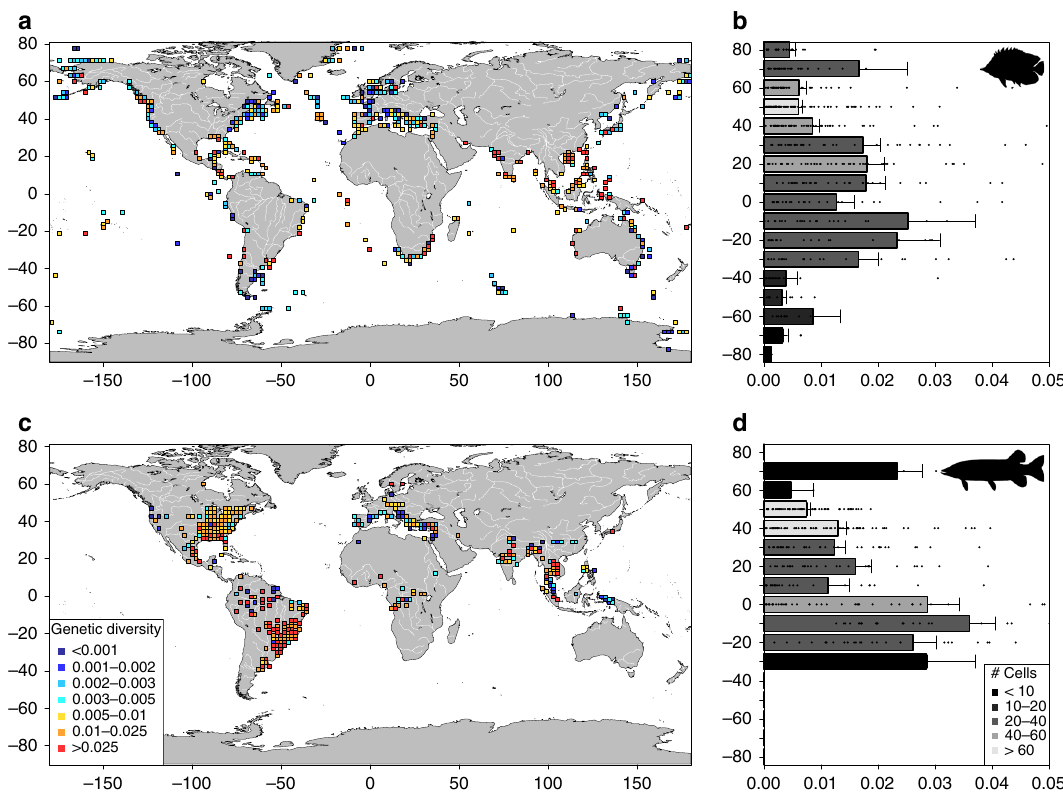
Fig. 1 Biogeographic patterns of fi sh genetic diversity. Genetic diversity was estimated as the mean number of mutations per base pair for Cytochrome Oxidase Subunit 1 sequence across species ( a ) 514 cells for marine fi shes and ( c ) 343 cells for freshwater fi shes. The colour gradient represents the relative variation of intraspeci fi c genetic diversity: the reddest square cells have the highest genetic diversity. The colour scale of Fig. 1a, c is de fi ned in the Fig. 1c: the bluest square cells have the lowest genetic diversity. Genetic diversity was averaged across cells within latitudinal band of 10° and is plotted as a function of latitude for marine species ( b ) and freshwater species ( d ) with error bars representing con fi dence intervals (standard deviation of mean genetic diversity across cells/square root of the number of cells) and indicates variability of genetic diversity among cells. The grey colour gradient indicates the number of cells used in each latitudinal band. The grey colour scale is de fi ned in Fig. 1d. For the fi sh silhouette in Fig. 1d, credit given to U.S. Fish and Wildlife Service (illustration) and T. J. Bartley with licence at: http://www.phylopic.org/image/f8369dec-bdf6-432b-a0c4-41ee5d75286d/. Drawn with R version